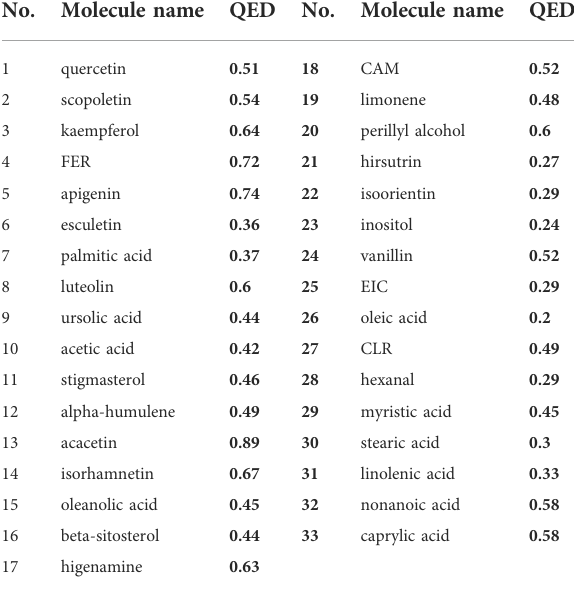
TABLE 2 Characteristics of active components in